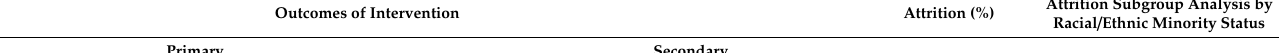
Outcomes of Intervention Attrition (%) Attrition Subgroup Analysis by Racial / Ethnic Minority Status Primary Secondary (b) Study outcomes of interventions in the systematic review of e ff ectiveness of prevention interventions for adolescents from ethnic / racial minorities (n = 24) Multicomponent